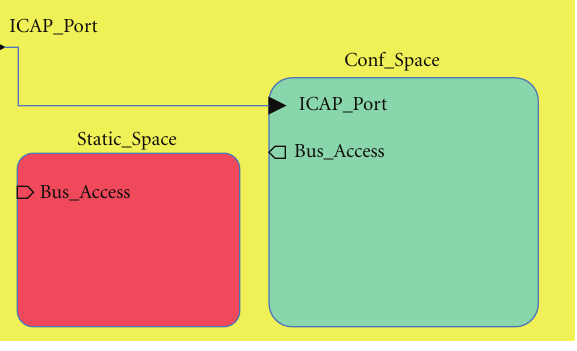
Figure 5: Graphical description of the composition of a generic FPGA with two main parts: static and configurable parts. The con- figurable part is connected to the configuration port which provides the dynamic and partial reconfiguration